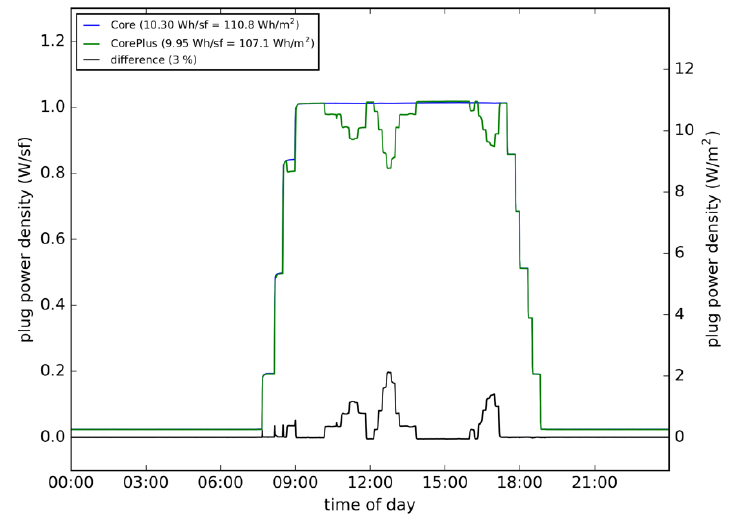
Figure 12. Hourly profile of plug loads with plug load controls (CorePlus) and without (Core). The di ff erence is also shown.